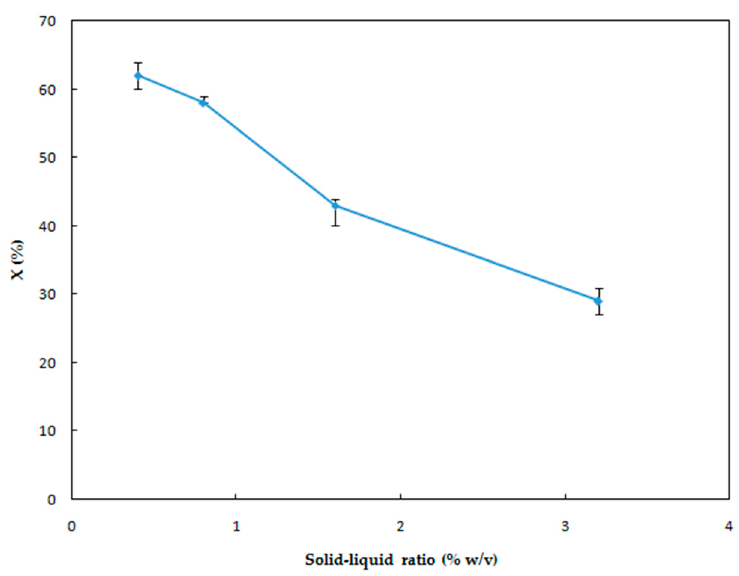
Figure 6. Effect of solid-liquid ratio on the dissolution of LiCoO 2 .